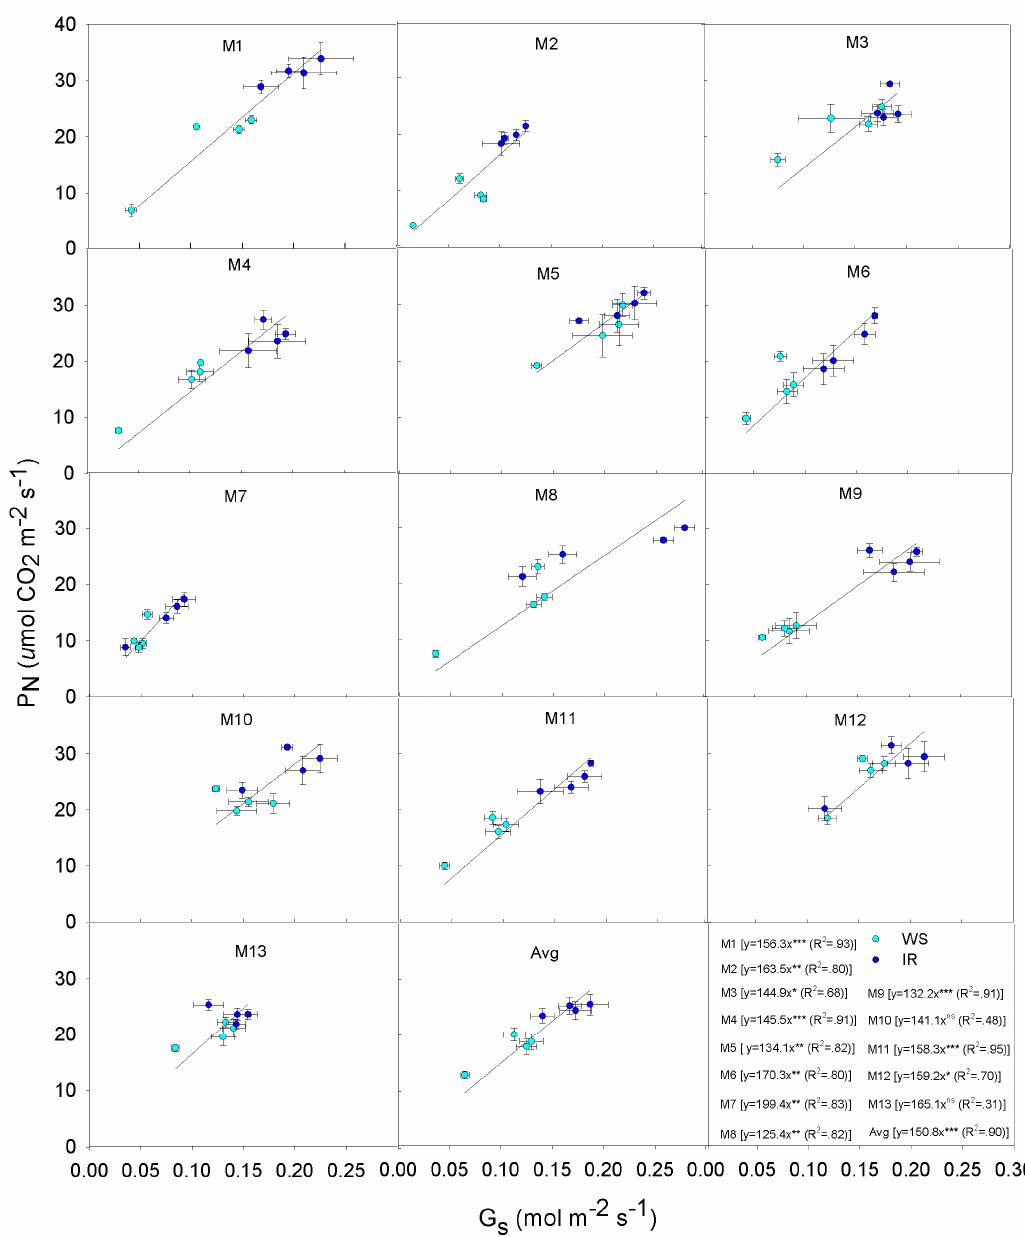
Figure 4. Relationships between stomatal conductance (Gs) and net photosynthesis (P N ) of Miscanthus genotypes under rainfed (WS) and irrigated (IR) conditions in 2014 (the second year following planting). Significant slopes per p ≤ 0.05 (*), p ≤ 0.01 (**), p ≤ 0.001 (***), and not significant (ns). The slope of the genotypic averages in Gs and E indicated an average rate of change of 3.64 mmol H 2 O m − 2 s − 1 for every 0.1 mol m − 2 s − 1 of Gs (Figure 5). All genotypes showed significant positive slopes, although the goodness of fit was variable (R 2 varied from 0.54 in genotypes M5 and M10 to 0.94 in genotype M8). Genotype M7 produced the steepest slope (3.64 mmol H 2 O m − 2 s − 1 ) but the narrowest distribution of data clustered in the lowest range of Gs values, and genotype M5 the narrowest distribution but clustered in the upper range of Gs values. Genotype M5 also had the lowest rate of change overall (2.89 mmol H 2 O m − 2 s − 1 increase for every 0.1 mol m − 2 s − 1 of Gs). The widest distribution of both irrigated and rainfed data was found for genotype M8, with a similar trend to the previous Gs-P N relationship.